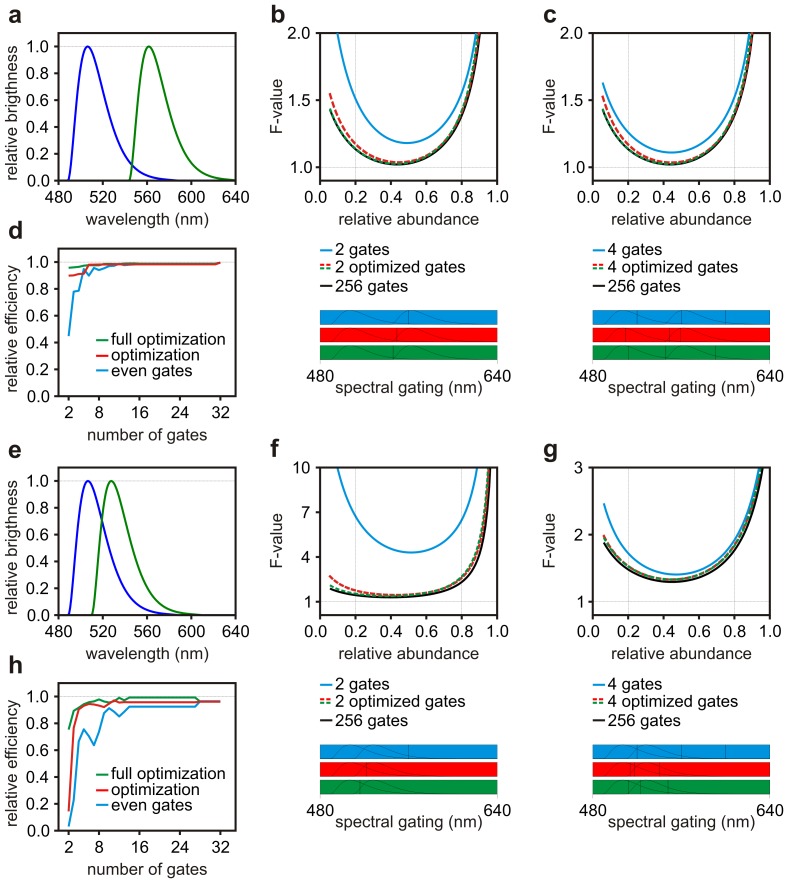
Optimization of spectral channels.Spectra representative of fluorophores like EGFP and mCherry (a) or EGFP and EYFP (e) were used to carry a numerical optimization of the spectral gating scheme as a function of the relative abundance of EGFP. Results are shown for a a system with 2 (b and f) and 4 (c and g) adjacent spectral channels which relative positions were set equal (blue) or optimized numerically by  (red) and followed by  (green) with optimization carried over the relative abundance range indicated by the vertical lines. The black curves represent performance that could be achieved with hyperspectral detection over 256 spectral gates. The spectral gating scheme is represented by the boxes at the bottom of panels b, c, f and g. The efficiency of the optimization strategies relative to hyperspectral detection achieved with 256 gates  is also plotted versus the number of gates (d and h).